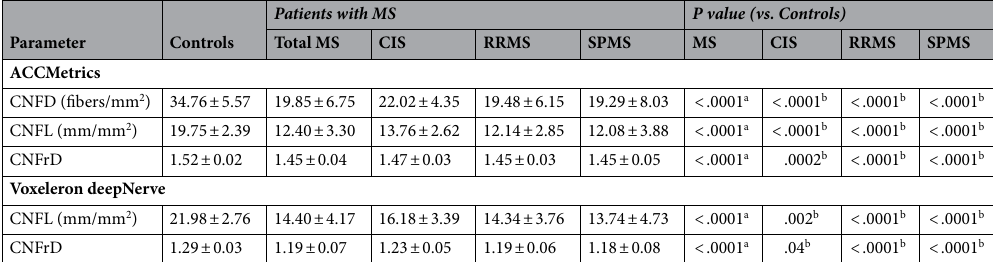
Table 2. CCM image quantification with ACCMetrics and Voxeleron deepNerve. CIS clinically Isolated Syndrome, RRMS relapsing remitting multiple sclerosis, SPMS secondary progressive multiple sclerosis, MS multiple sclerosis, CNFD corneal nerve fiber density, CFL corneal nerve fiber length, CNFrD corneal nerve fractal dimension. Data are expressed as mean ± standard deviation. a Unpaired t -test. b One-way analysis of variance.